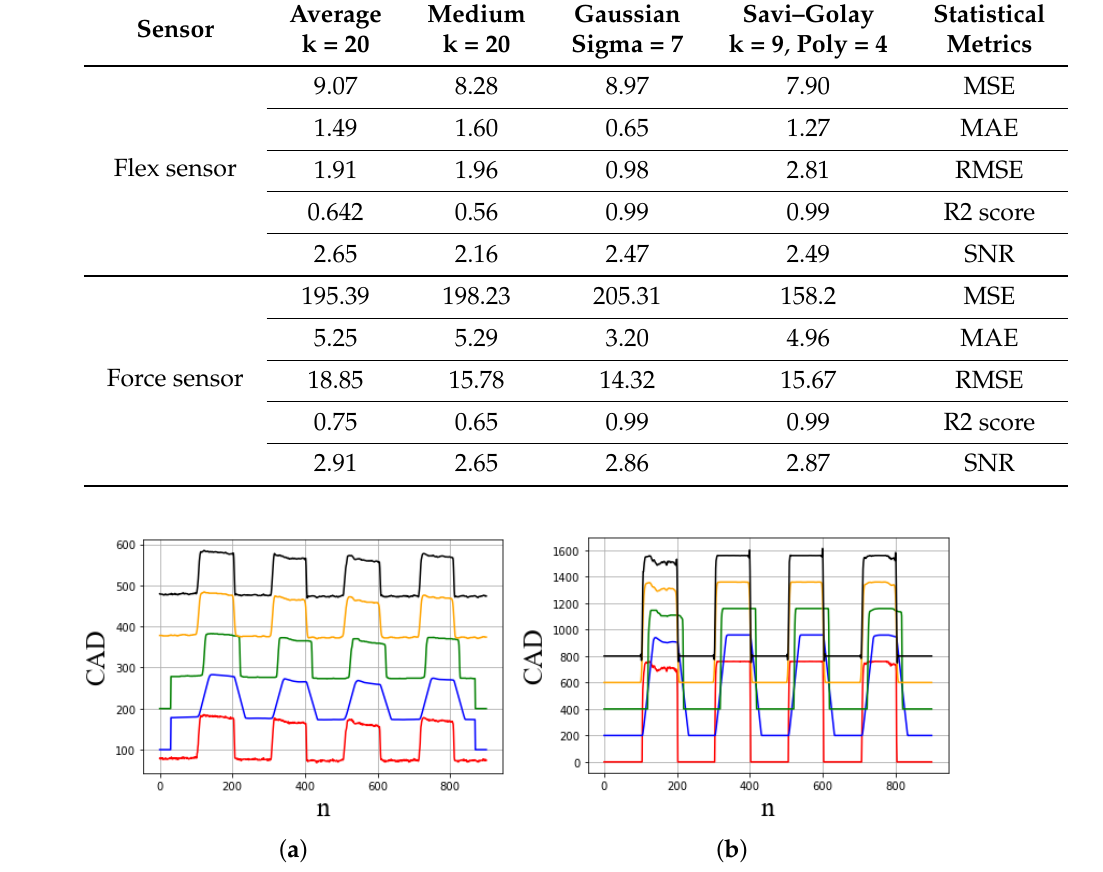
Table 4. Statistical analysis of sensors with various sampling rates.